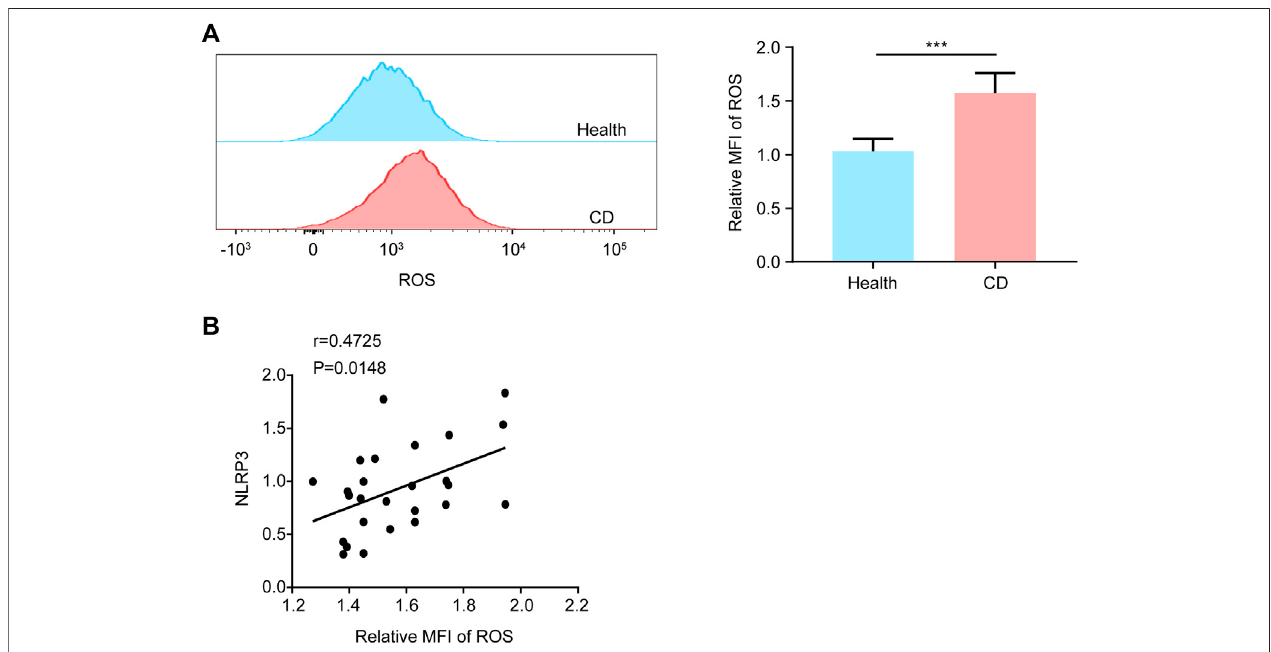
FIGURE 4 | Increased ROS generation in platelets from patients with active Crohn ’ s disease (CD). (A) We explored the ROS generation by fl ow cytometry in platelets from the healthy group ( n (cid:2) 26) and patients with active CD ( n (cid:2) 26). The relative quanti fi cation was at right. (B) The NLRP3 protein levels were positively correlatedwithROSlevelsinplateletsfrompatientswithactiveCD( n (cid:2) 26).Health,thehealthygroup;CD,thepatientswithactiveCD.Dataarepresentedasmean ± SD, *** p < 0.001.